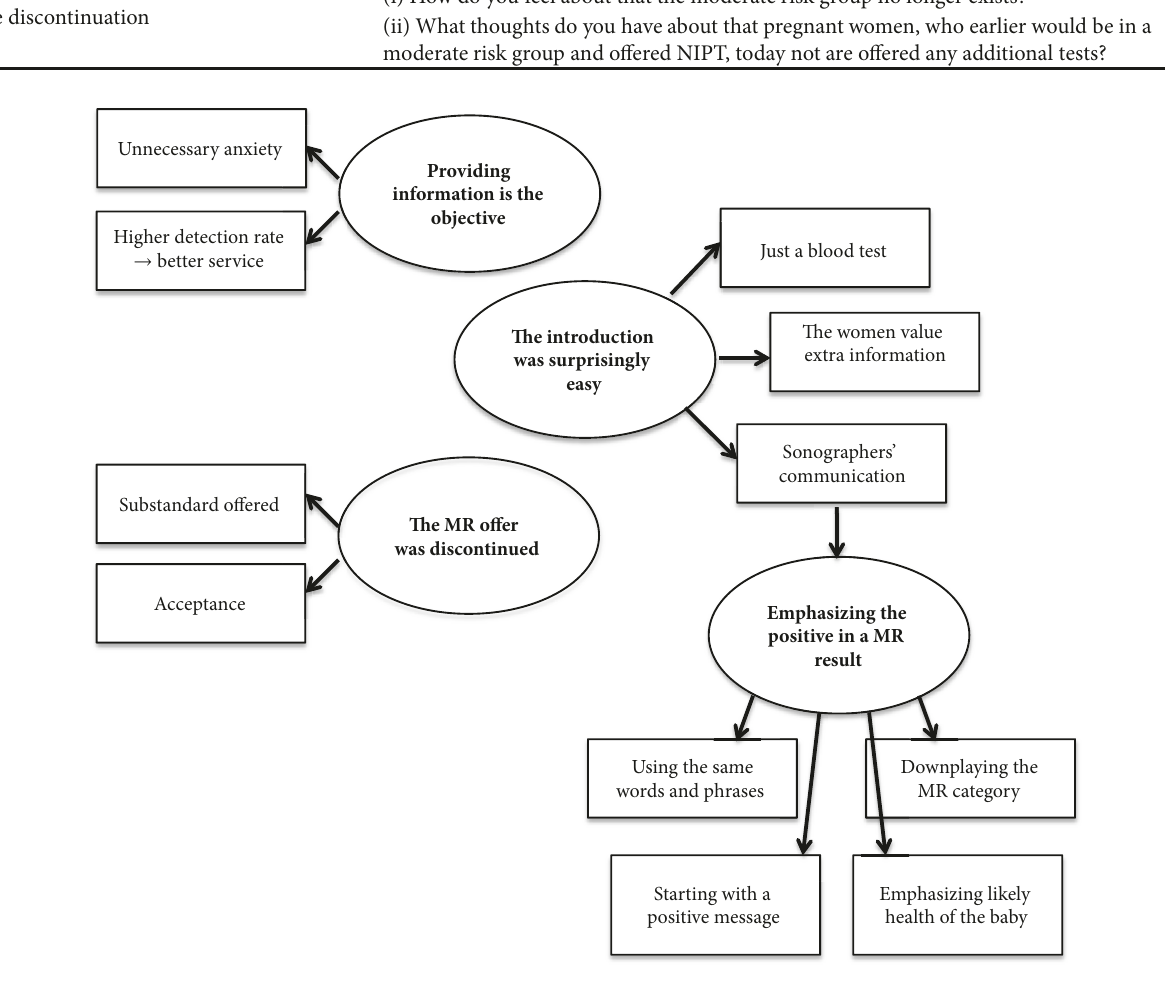
Figure 1: Thematic